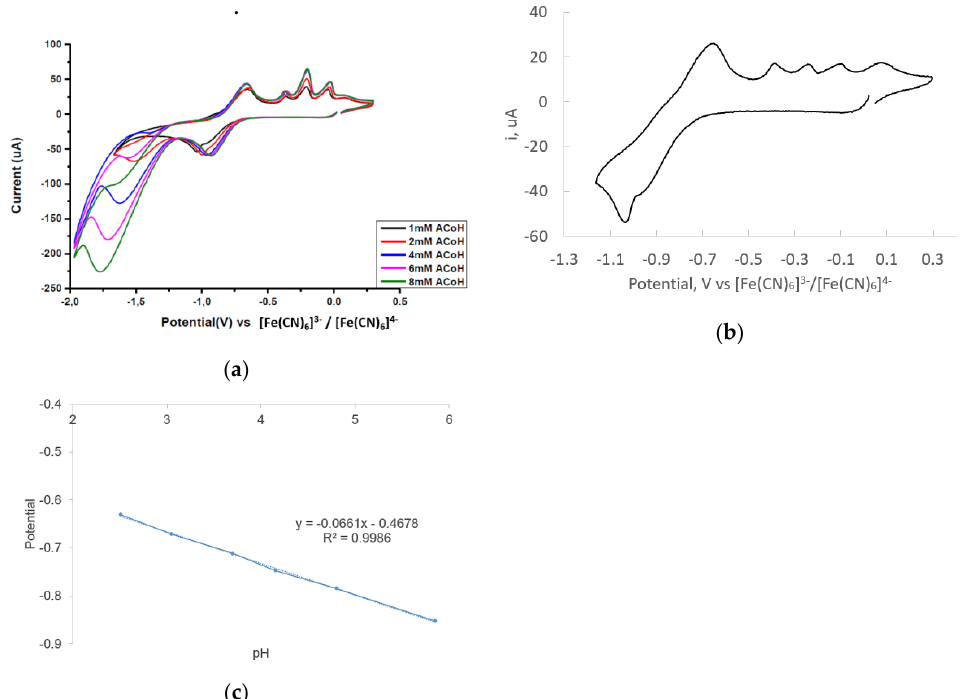
Figure 5. ( a ) CVs of [1] + (0.5 mM) in the presence of various concentrations of AcOH (1.0–8.0 mM) recorded in an aqueous solution of NaCl (0.1 M) on a glassy carbon electrode at a scan rate of 0.1 V s −1 ( b ) CV of [1] + (0.5 mM) in the presence of 2 mM of acetic acid recorded in an aqueous solution of NaCl (0.1 M) on a glassy carbon electrode at a scan rate of 0.1 V s −1 in the potential window of 0.3 to −1.1 V ( c ) Pourbaix diagram (reduction potential vs pH): the reduction potential of the first CV peak vs [Fe(CN) 6 ] 3− / [Fe(CN) 6 ] 4− shifts linearly with the pH value in the pH range of 2.5–6.0, with a slope of 0.066 mV per pH unit. The respective CVs were recorded in aqueous solutions of [1] + (0.5 mM) in the presence of CH 3 COOH/CH 3 COONa buffer.